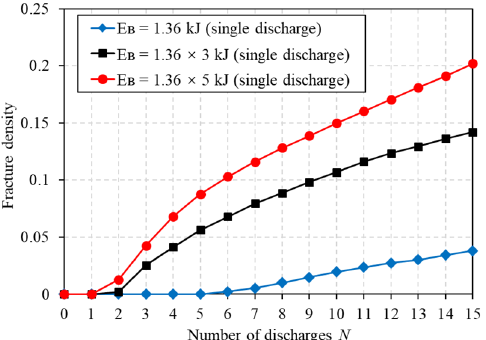
Figure 17. Variation of fracture density under different discharge energies when P c = 1 MPa and P h = 0 MPa.